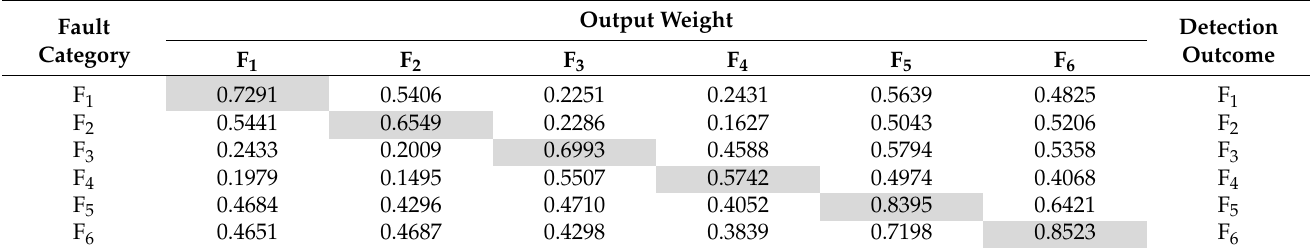
Table 7. Detection outcomes of the inverter at 120 Hz with different fault